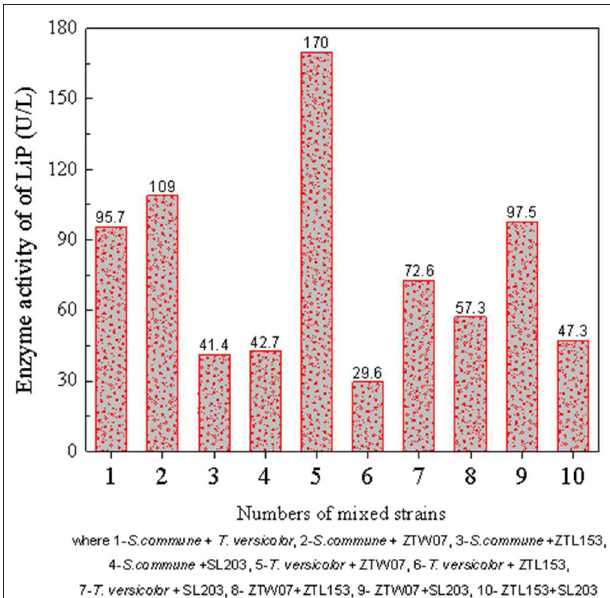
FIGURE 4 | Comparison of the activity of mixed strains on day 9.